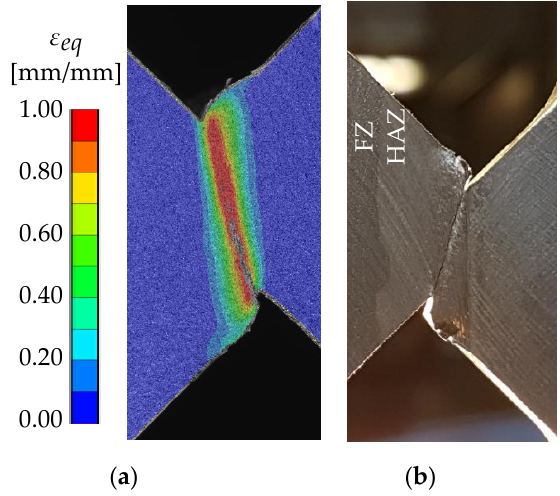
Figure 11. ( a ) Strain distribution at 3.25-mm displacement and ( b ) the backside of the specimen at about 3.5-mm displacement.